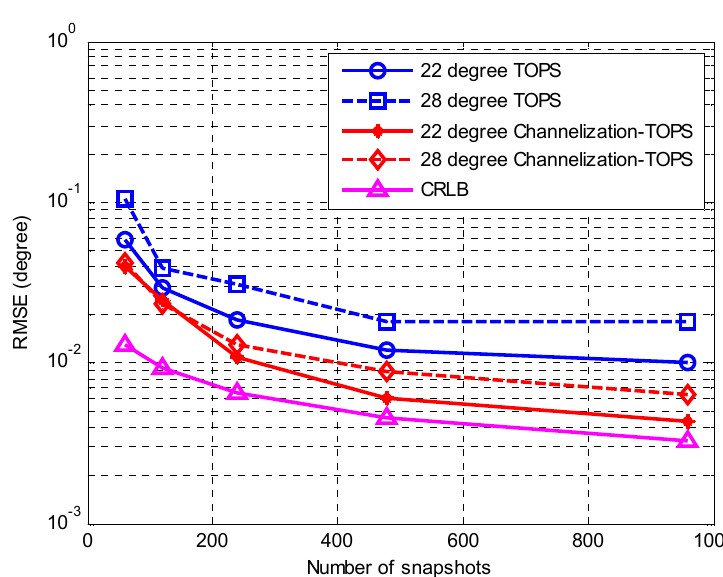
Figure 6. RMSE of the DOA estimates against the number of snapshots.